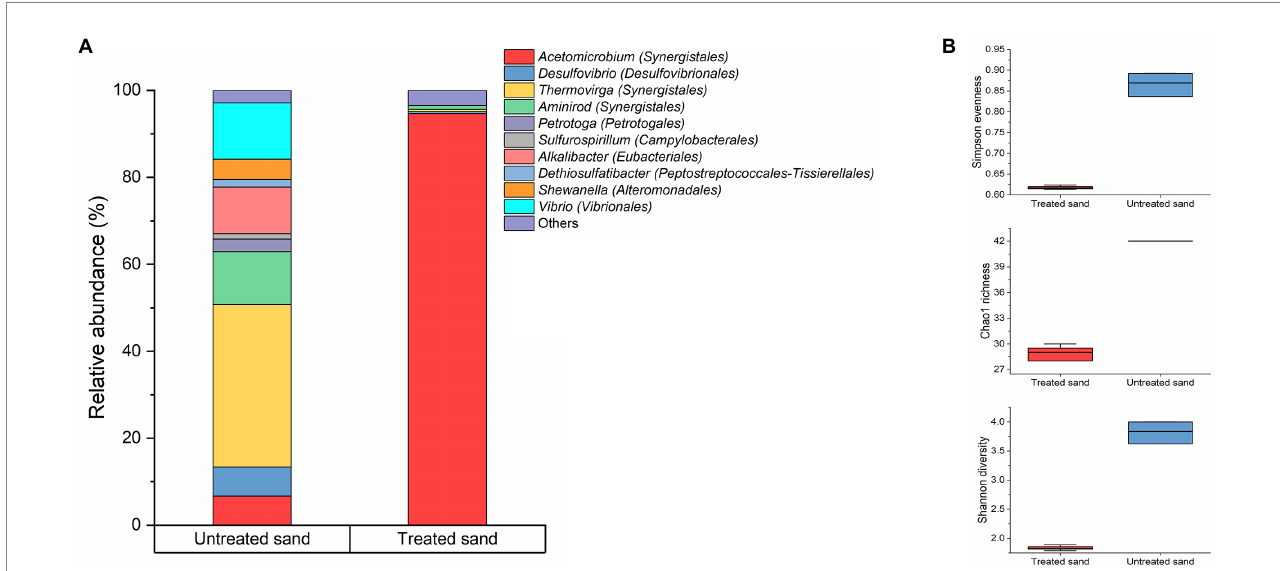
FIGURE 4 Microbial community changes driven by the sand-deposit chemical composition. (A) Community structure. Results show the mean relative abundances of microbial community classified at the genus level ( n = 3). Phylogenetic order is indicated in parentheses. Bacterial genera with relative abundances >1% are shown; genus contributing ≤ 1% were presented as “others.” (B) Alpha diversity analysis. Boxes represent the interquartile range (IQR) between the first and third quartiles (25th and 75th percentiles, respectively), and the horizontal line inside the box defines the median. Whiskers represent the lowest and highest